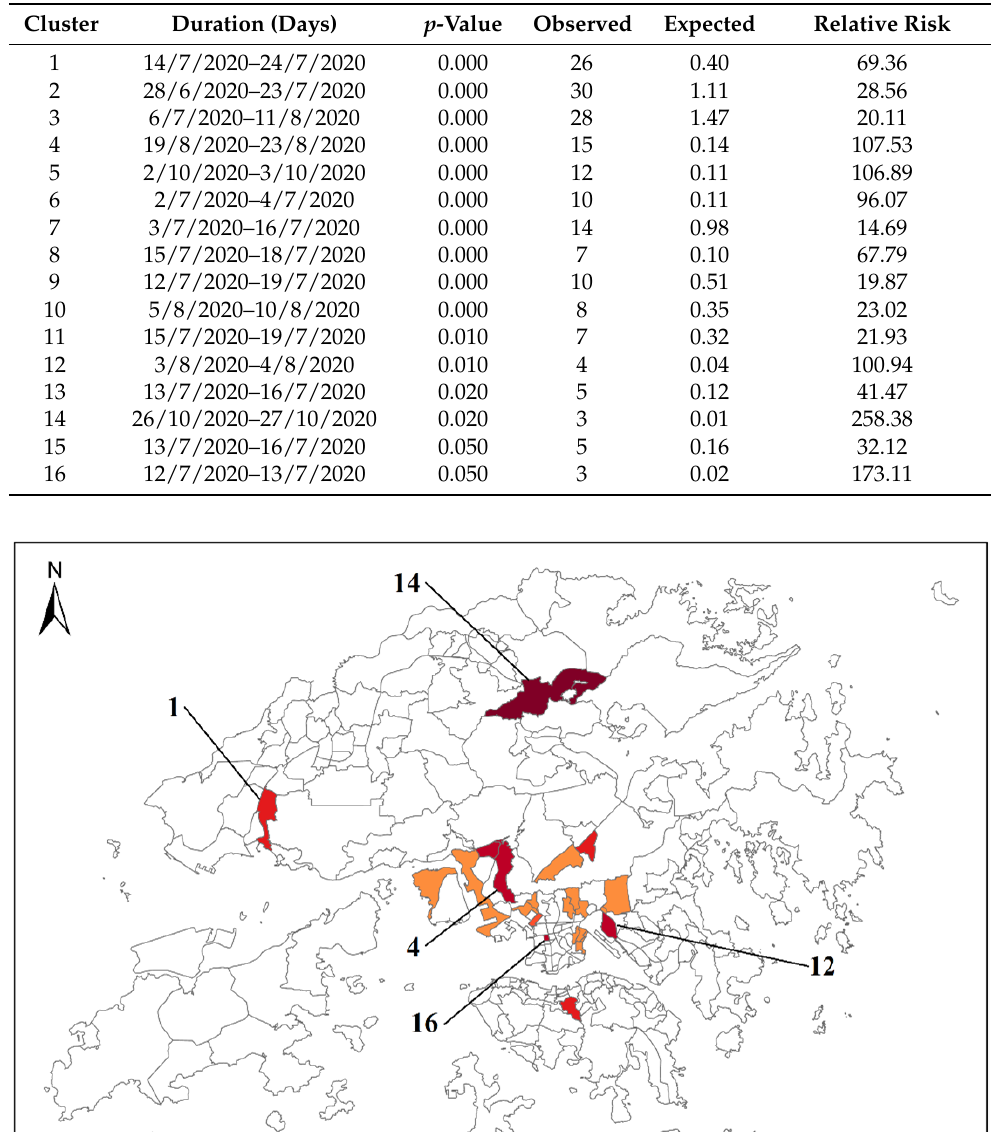
Table 4. Space–time clusters in stage II of COVID-19 transmission in residential locations in Hong Kong.